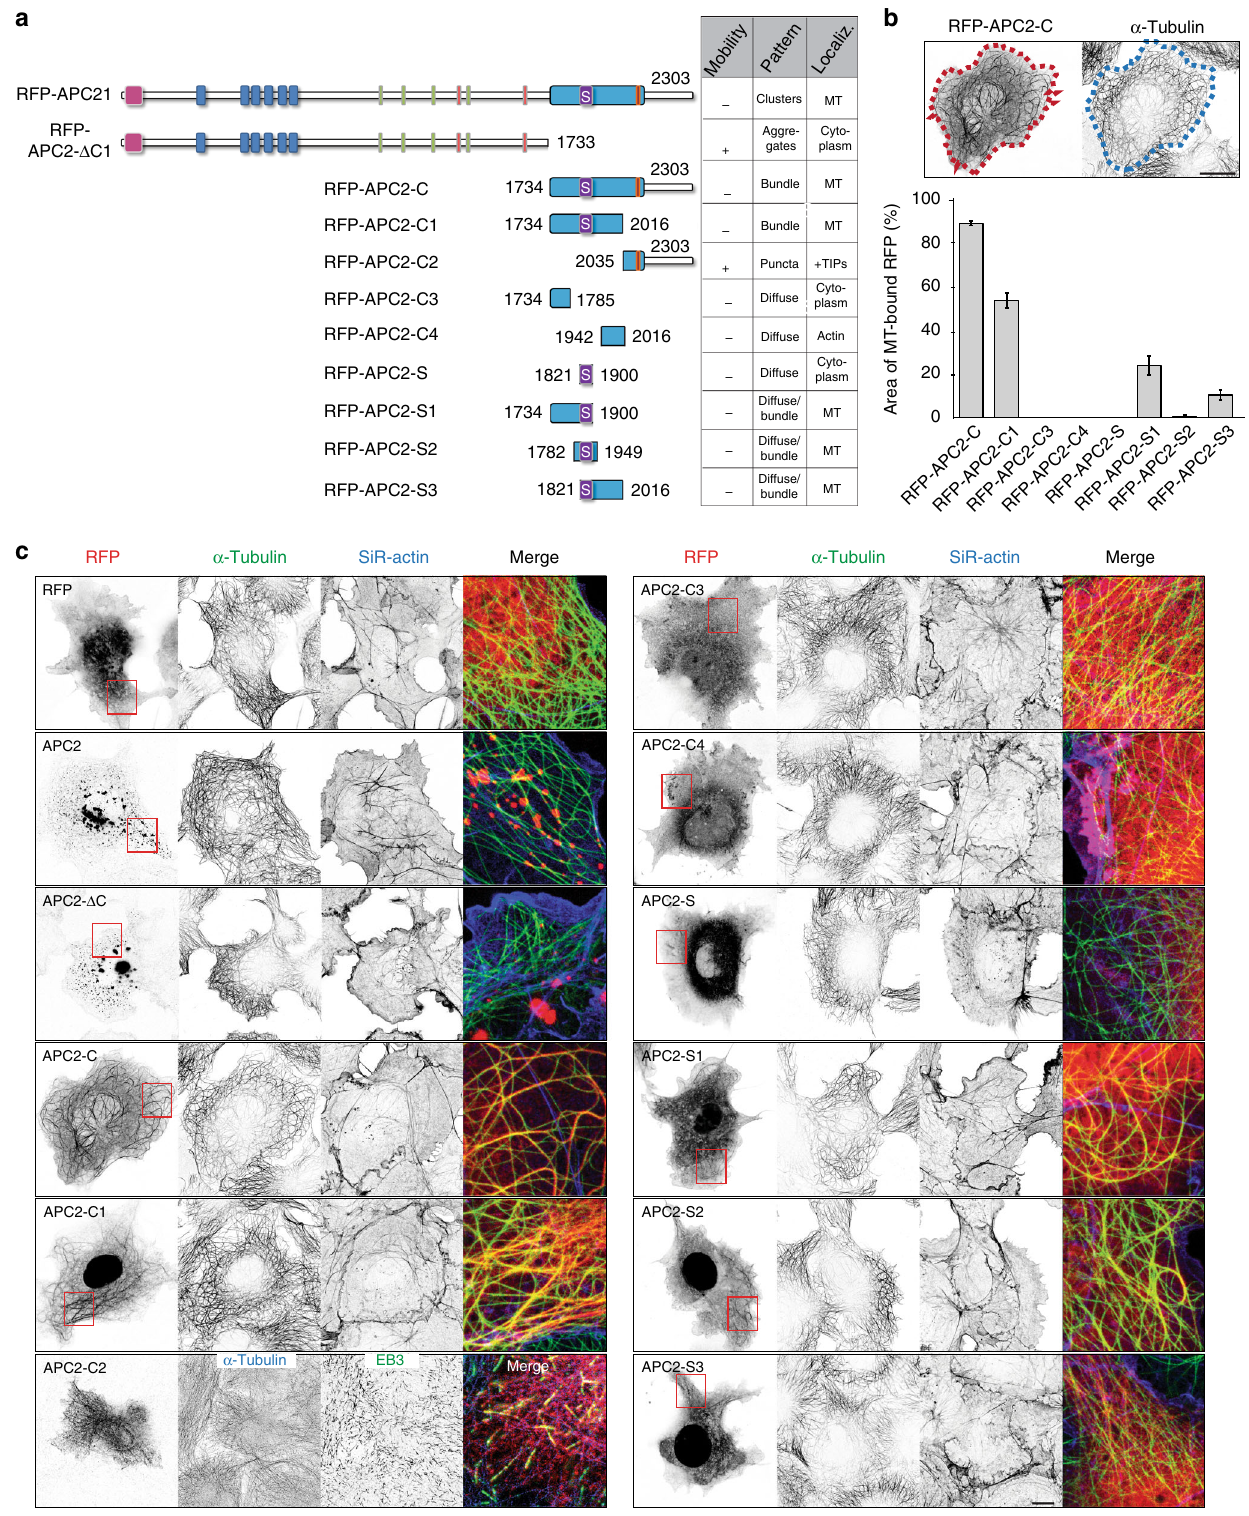
Fig. 5 Functional domains of APC2 cytoskeleton interacting region. a Schematic representation of human APC2 protein truncations generated for these experiments. Table shows whether the expressed truncations are mobile, what pattern their localization follows and what region of cell they are localized to. b Representative images of area of microtubules decorated with RFP-APC2-C in Cos7 cells (red dotted line) and total area occupied by microtubules of same cell (blue dotted line) are shown. Percentage of area of microtubule bound construct (e.g., red dotted line) over total microtubule occupied area of cells (e.g., blue dotted line) was measured and used to determine af fi nity of the truncations for microtubules ( n = 50 cells, N = 2). c Representative images of truncated proteins expressed in Cos7 cells for 24 h before fi xation and staining for tubulin, actin and EB3. Graphs represent mean ± SEM. Scale bars are 10 µ